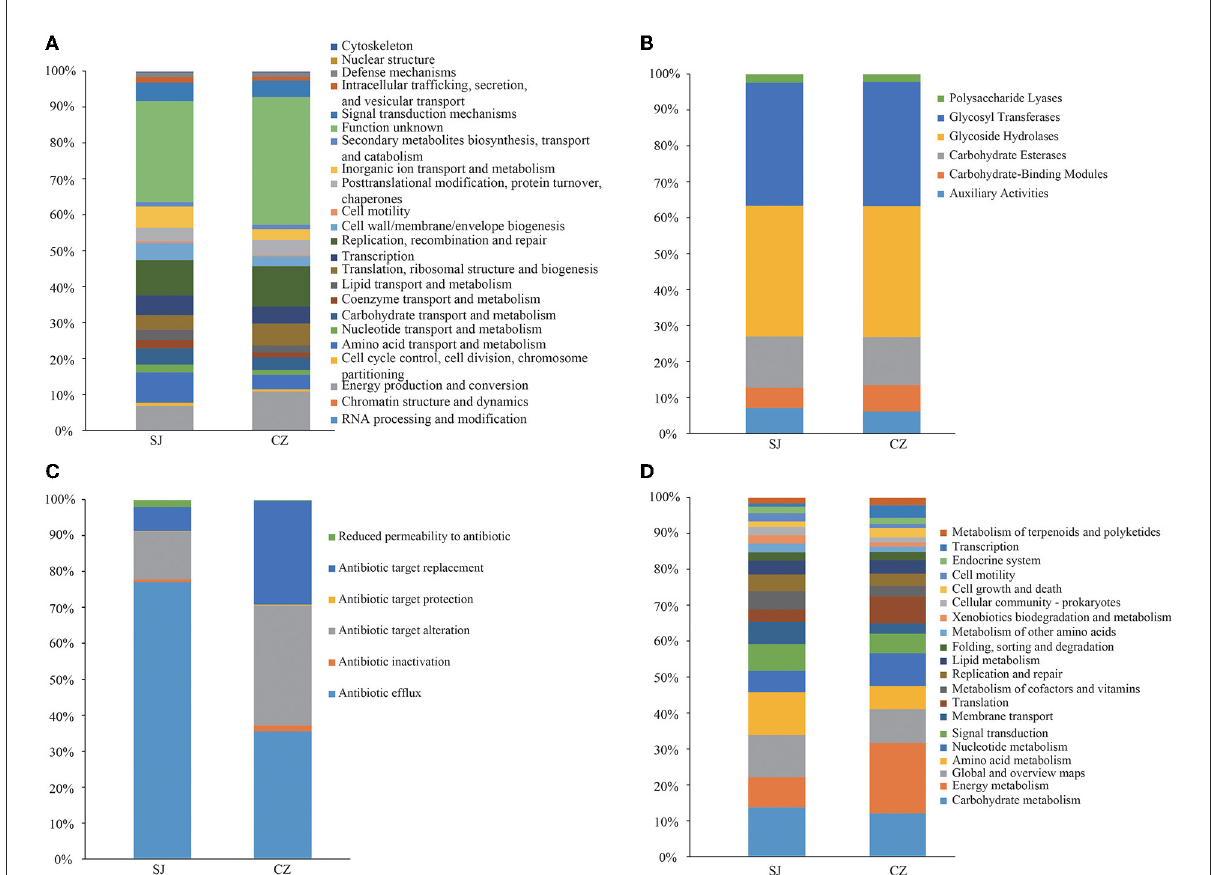
FIGURE3 Functional predictions of Anser erythropus gut microbial communities from Shengjin (SJ) and Caizi (CZ). Lakes based on the Evolutionary Genealogy of Genes: Non-supervised Orthologous Groups (eggNOG)_description (A) , Carbohydrate-Active Enzymes (CAZy) (B) , Comprehensive Antibiotic Resistance Database (CARD) (C) , and Kyoto Encyclopedia of Genes and Genomes (KEGG) (D)